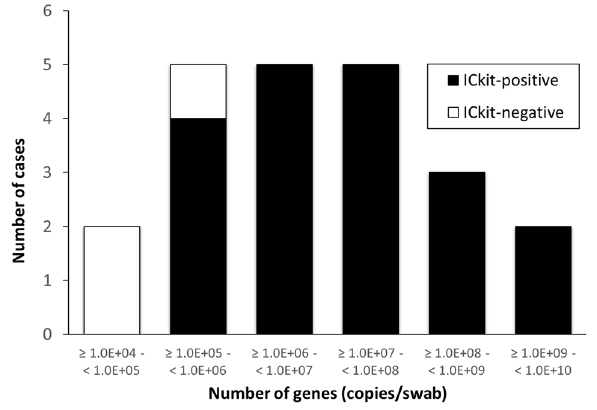
Figure 2. The relationship between the results of the ICkit and the number of IS481 genes by rPCR. A total of 22 positive cases were analyzed by rPCR. In the three negative cases, IS481 genes were detected by rPCR, but the